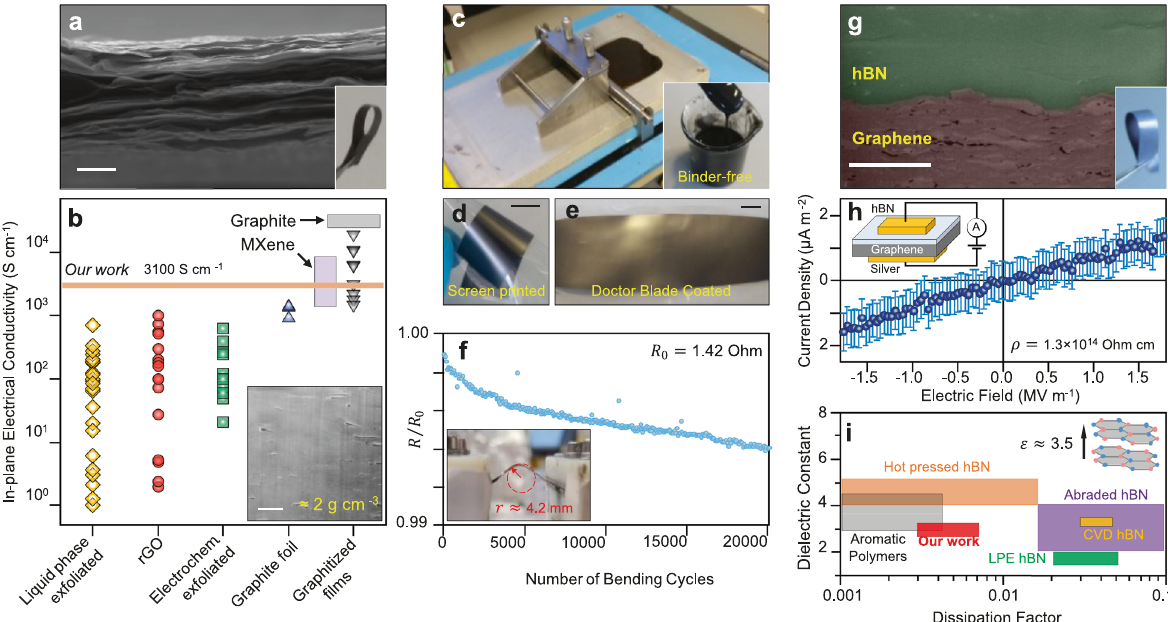
Fig. 5 Example applications for the exfoliated graphene and hBN 2D sheets. a Cross-sectional SEM image of the free-standing graphene laminate. Scale bar: 5 µm. Inset: Photograph of a bent laminate strip. b Comparison of the in-plane electrical conductivity of our graphene laminate (horizontal orange band marking 3100 ± 250 S cm − 1 ) with graphene and MXene laminates 51 , graphitic fi lms 42 , and pyrolytic graphite 52 (see Supplementary Table 2). Inset: Cross-sectional SEM image of the same laminate prepared using focused ion beam (FIB) milling to resolve the compactness of the sample (density ≈ 2 g cm − 3 ). Scale bar: 500 nm. c A demonstration of the coating process of a PET fi lm with a binder-free graphene/NMP slurry using conventional doctor blade coater. Inset: Photograph of the graphene/NMP slurry. This slurry can either be screen printed ( d ) or blade coated ( e ) on a polymer substrate. Scale bars in d , e : 2 cm. f Changes in surface resistivity versus the number of bending cycles for a graphene-coated paper (density 1.4 mg cm − 2 ). Inset: The graphene-coated paper in the test jig bent to the minimum radius of 4.2 mm. g Colourised cross-sectional SEM image of the hBN/graphene hybrid laminate. The fi lm was cross-sectioned using FIB milling. Scale bar: 5 µm. Inset: Photograph of a bent hBN/graphene laminate strip. h The current – voltage characteristics of the hBN laminate across its thickness. The electrodes are formed by the bottom graphene laminate on one side, and by a small droplet of a silver adhesive on the other. Error bars are one standard deviation. i Comparison chart of the dielectric constant and dissipation factor of the hBN laminate described in the main text with dielectric properties of different types of dielectrics (see Supplementary Table (Fig. 5h), which is comparable with the resistivity of hot-pressed hBN ceramics 43 . The low-frequency (10 kHz) dielectric constant of the hBN laminate determined in capacitance measurements was determined to be ε ¼ 3 : 3± 0 : 3, close to the single-crystal value 44 . The dielectric was also characterised by a surprisingly low value of the loss tangent tan δ (cid:1) 0 : 003 45 (Supplementary Fig. 30).